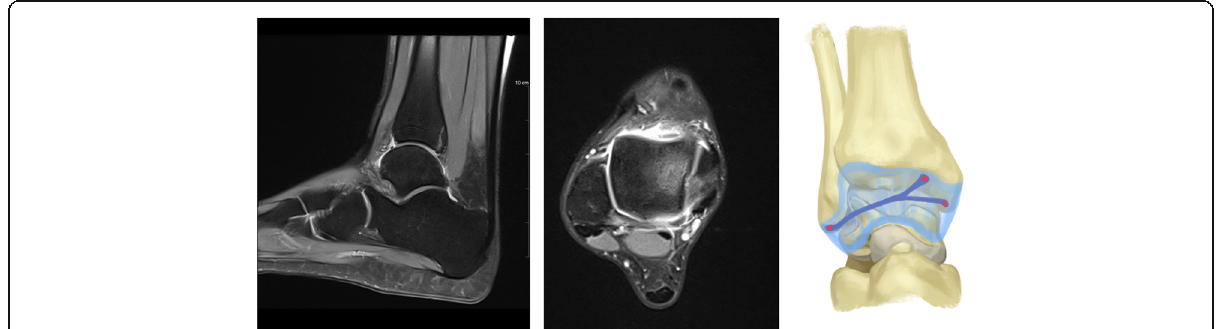
Fig. 3 Sagittal and axial MRI views, and the shape of the fibrous band in patient 2